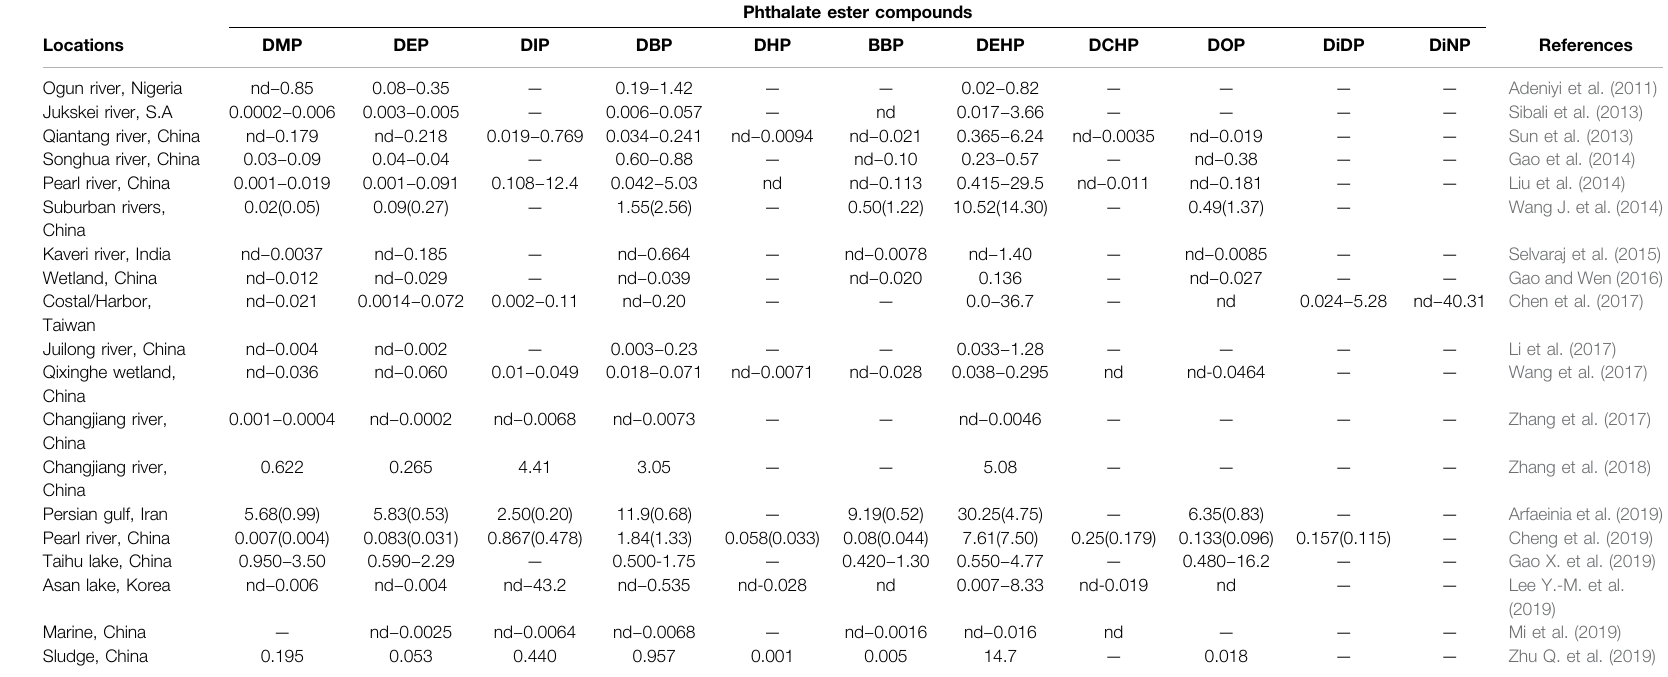
Phthalate ester compounds